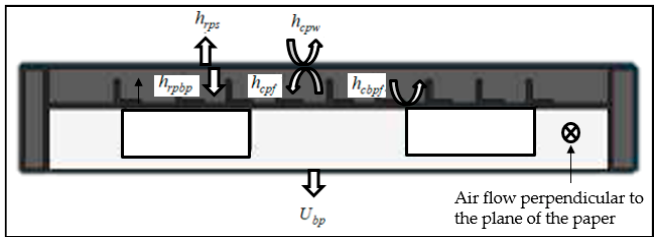
Figure 3. The thermal schematic model of a finned single pass PV/T air solar collector .